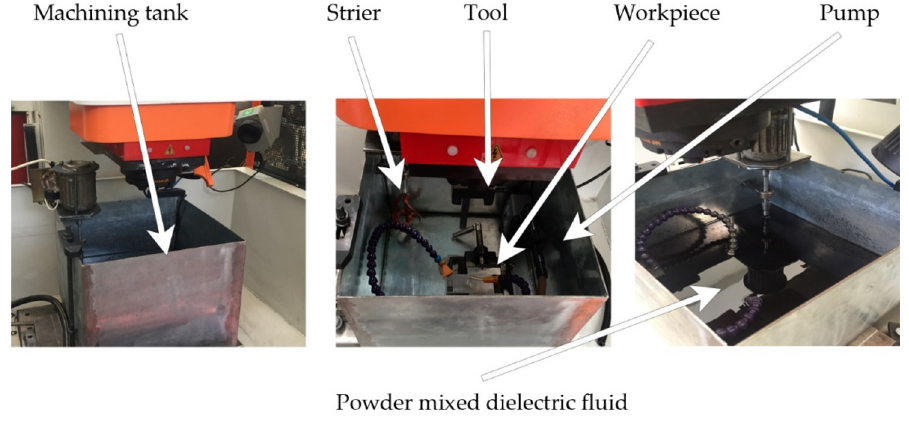
Figure 1. Setup of PMEDM.